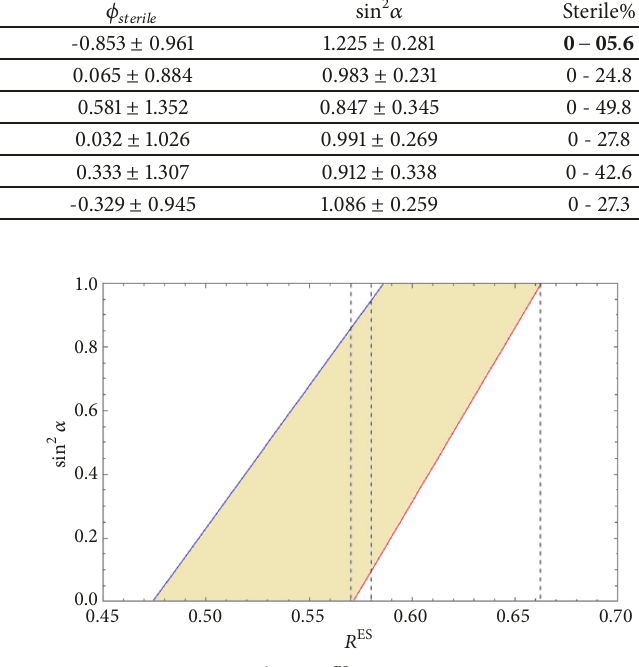
Figure 4: 1𝜎 plot of sin 2 𝛼 vs R 𝐸𝑆 zoomed for overlapping region of KamLAND, Borexino Phase-I, and Borexino Phase-II. Vertical dotted lines correspond to R 𝐸𝑆 equal to 0.57 , 0.58 , and 0.66